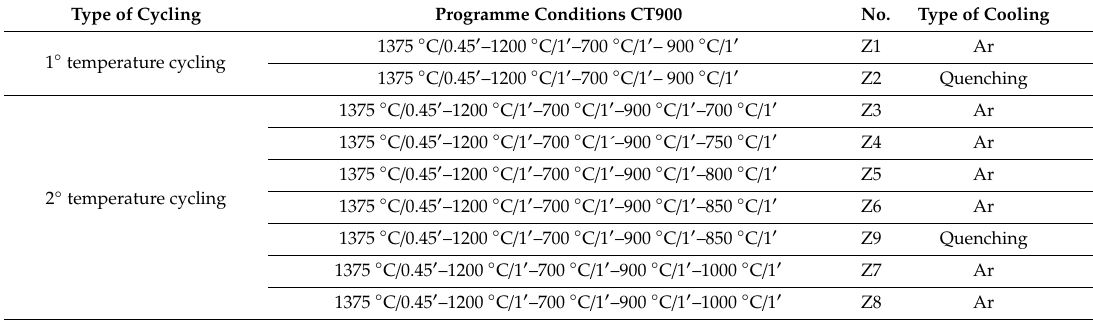
Table 3. Temperature cycling conditions near the temperature range of the phase transformation γ → α